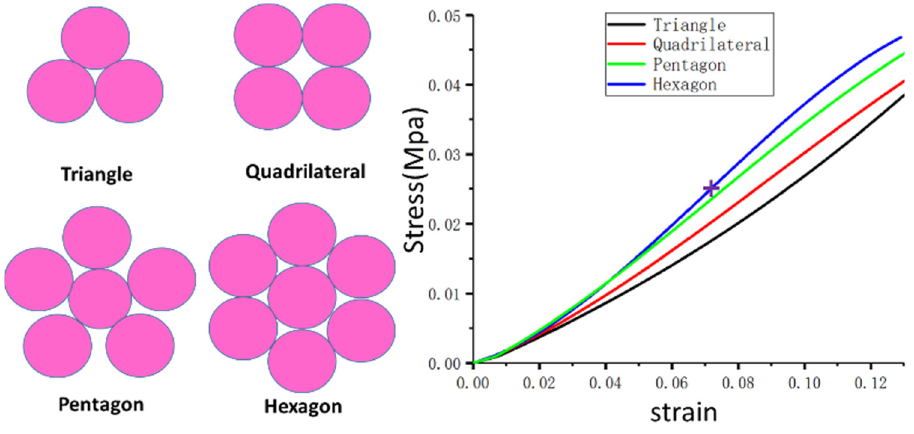
Figure 3. Stress–strain curves of different winding methods.